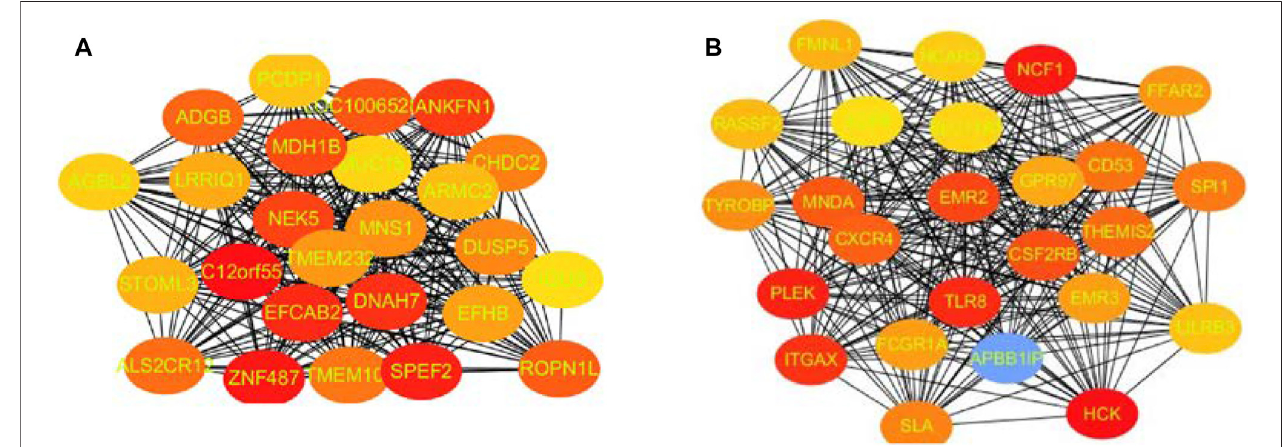
FIGURE 5 | Top 25 hub genes calculated by MCC algorithms have strong correlations with early lung cancer. Progressively darker red color represents higher relationship in the blue module. C12orf55, ZNF487, EFCAB2, and ANKFN1 are the most closely related hub genes (A) . The hub genes were identi fi ed by MCC in the brown module. NCF1, PLEK, TLR8, and HCK are the most closely related hub genes in the brown module (B)